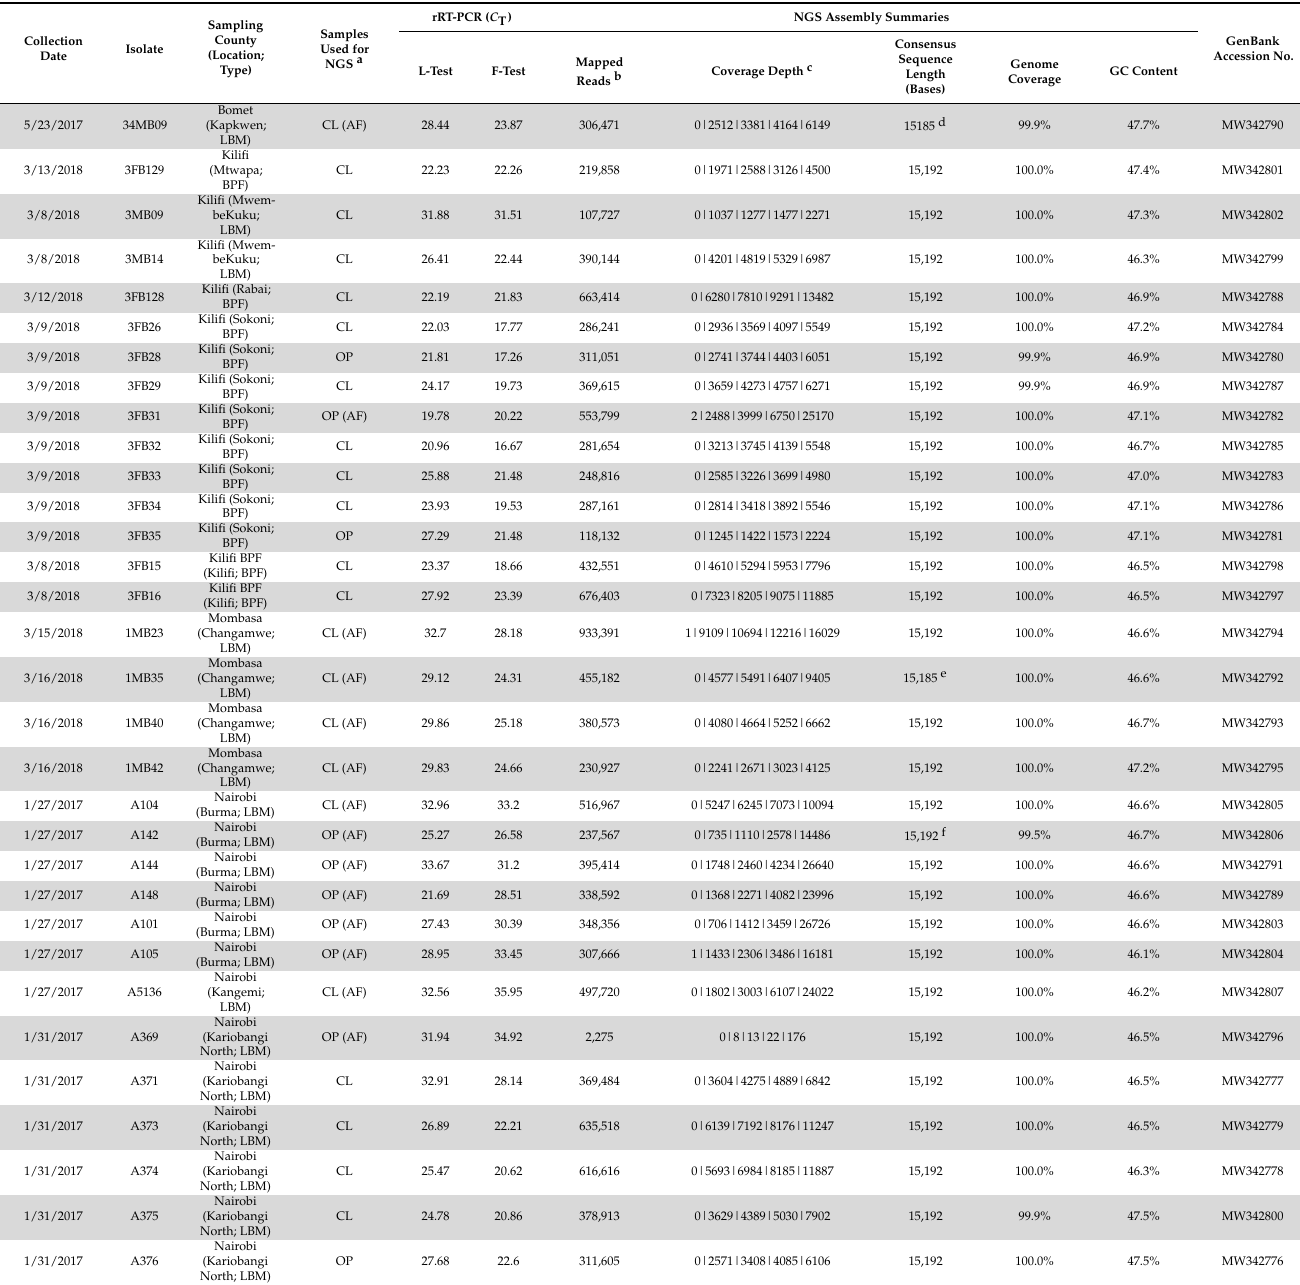
Table 2. Details of 32 samples from which NDV was successfully isolated and complete genomes obtained by next-generation sequencing (NGS) in the current